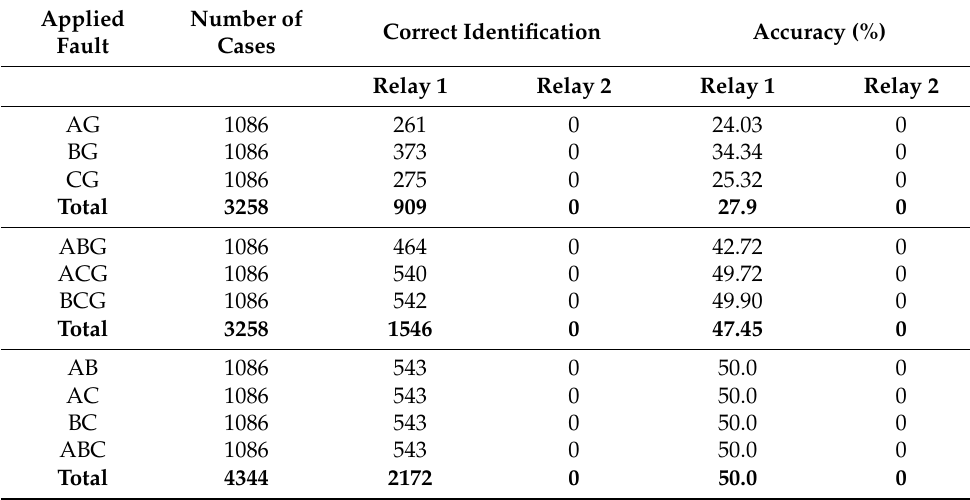
Table 3. Overall performance of relays for various fault